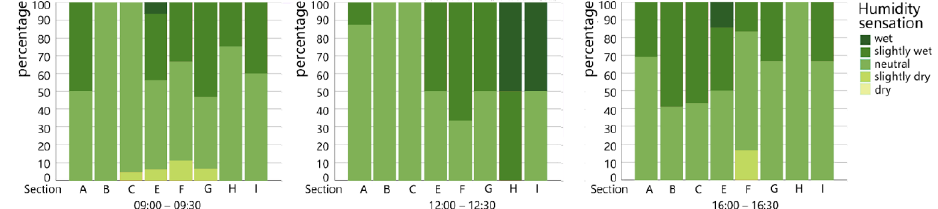
Figure A3. Humidity sensation votes of the three time periods on 11 September.